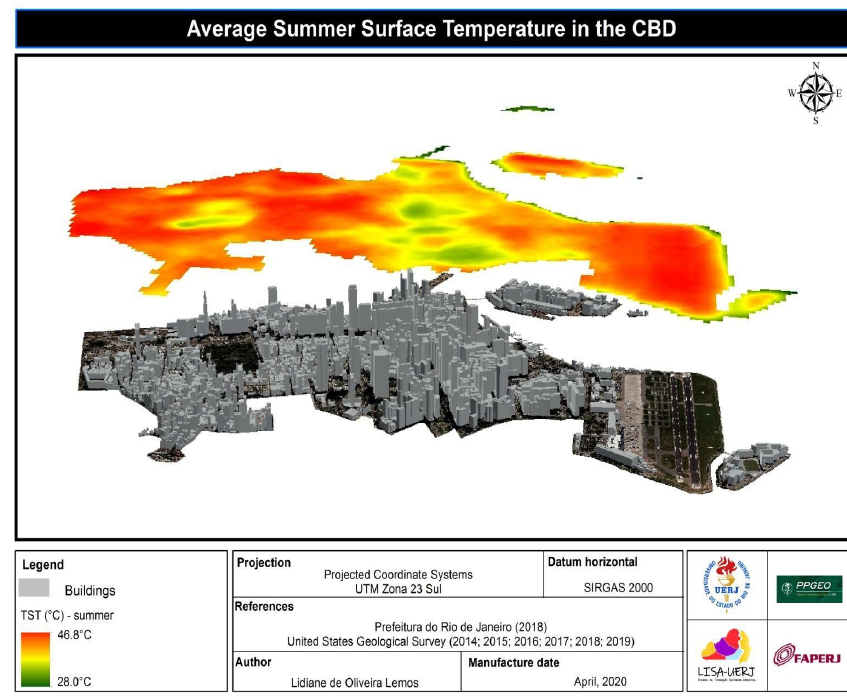
Figure 4. Average summer surface temperature in the CBD.